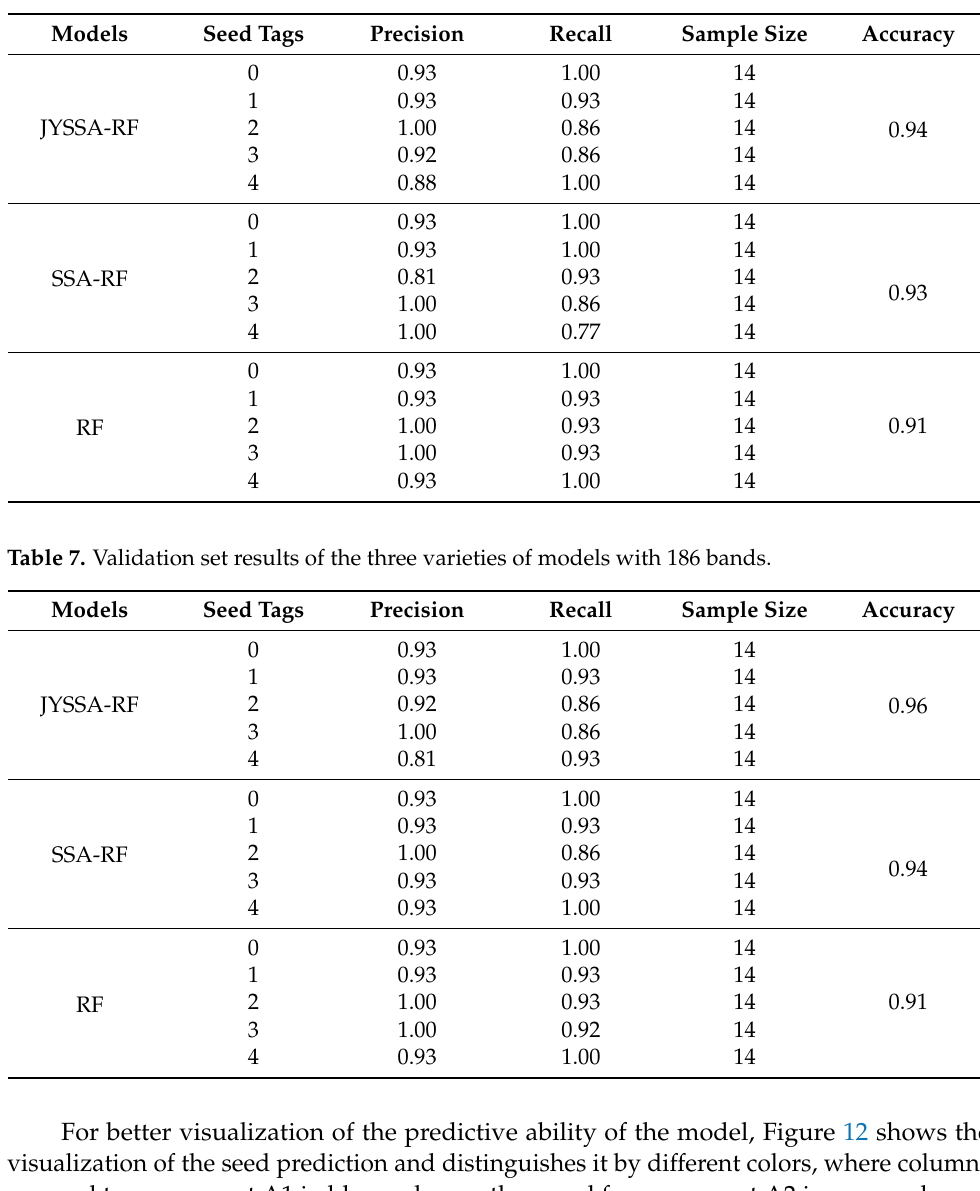
Table 6. Validation set results of the three varieties of models with 462 bands.